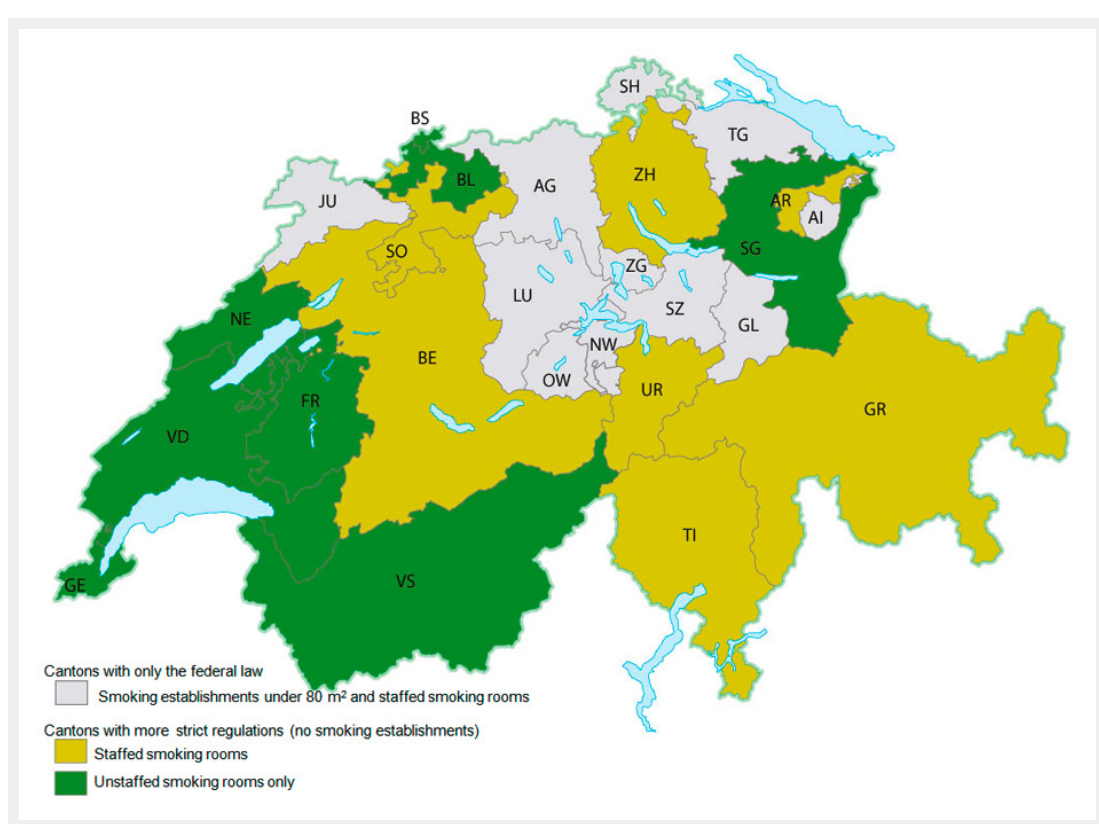
Map of the different cantonal legislations regarding exposure to second-hand tobacco smoke. AG: Aargau; AI: Appenzell Innerrhoden; AR: Appenzell Ausserrhoden; BE: Bern; BL: Basel-Landschaft; BS: Basel-Stadt; FR: Fribourg; GE: Geneva; GL: Glarus; GR: Graubünden; JU: Jura; LU: Lucerne; NE: Neuchâtel; NW: Nidwalden; OW: Obwalden; SG: St. Gallen; SH: Schaffhausen; SO: Solothurn; SZ: Schwyz; TG: Thurgau; TI: Ticino; UR: Uri; VD: Vaud; VS: Valais; ZG: Zug; ZH: Zurich. (Figure courtesy of the Swiss Lung